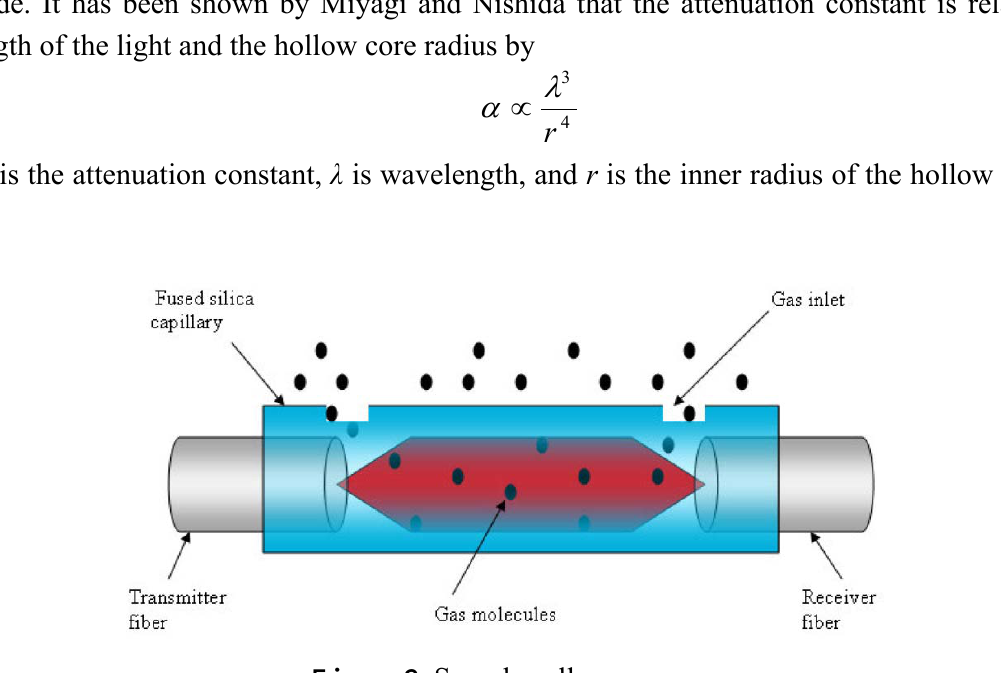
Figure 2. Sample cell gas